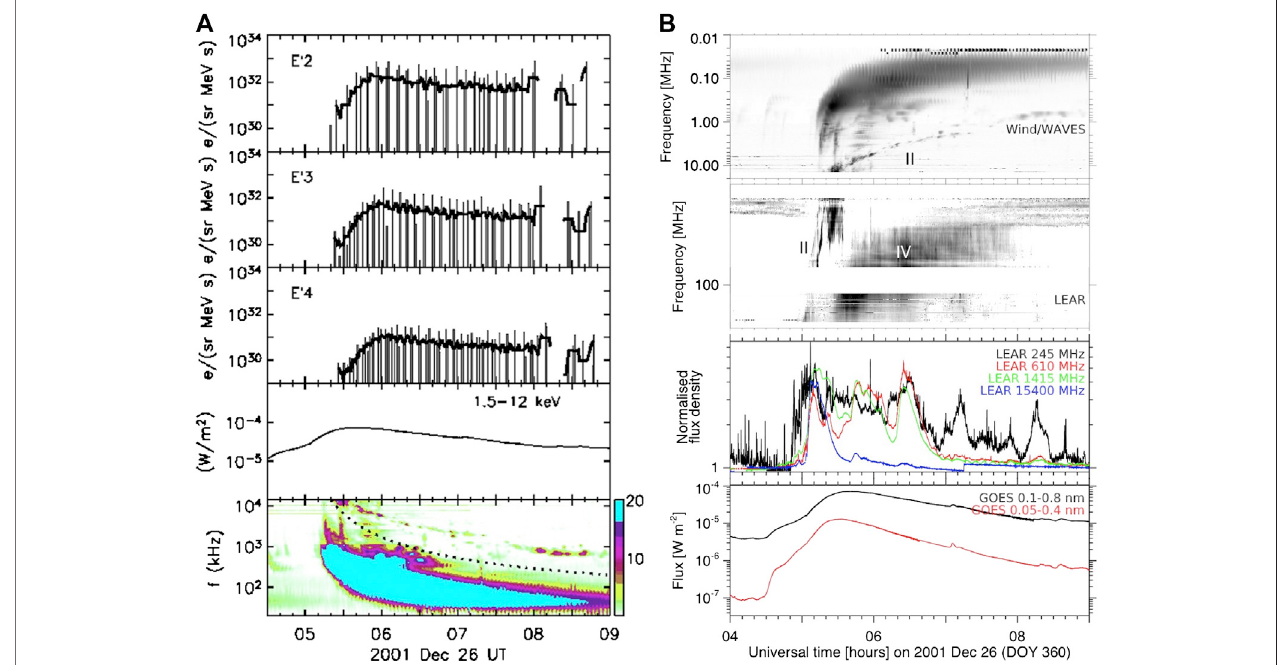
FIGURE 4 | Time histories of electron release, soft X-ray and radio emission during a large SEP event. (A) Injection delta-functions derived from the modeling of electrons in three energy channels of ACE/EPAM (three upper panels) compared with the soft X-ray fl ux (0.1 – 0.8 nm; second from bottom) and the dynamic radio spectrum between 14 MHz and about 10 kHz (bottom panel; vertical axis shows frequencies, increasing from bottom to top). From Agueda et al. (2009). ©ESO. Reproducedwithpermission. (B) SoftX-ray(bottom)andradiotimehistories(secondfrombottom),radiospectrumfrom180MHzto10kHz(frequencydecreasing from bottom to top). Bursts of types II and IV are marked. Adapted from server.